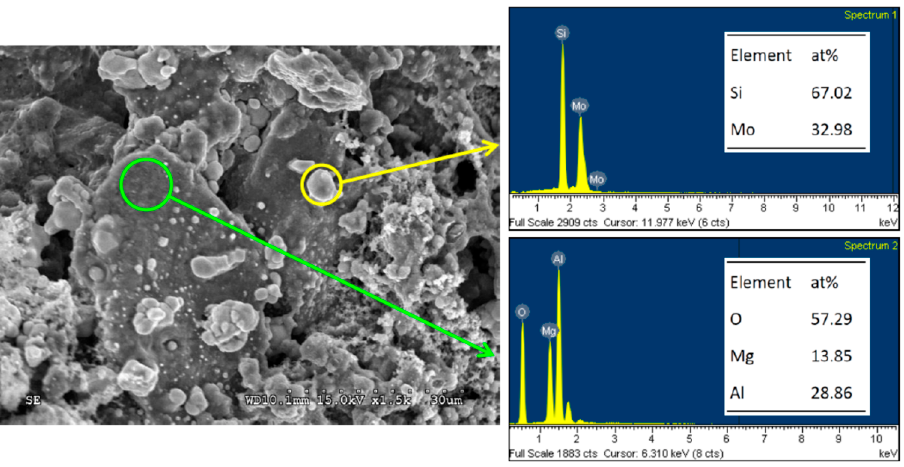
Figure 10. SEM image with EDS element spectra of MoSi 2 –MgAl 2 O 4 composite synthesized from R(3) with z = 3.